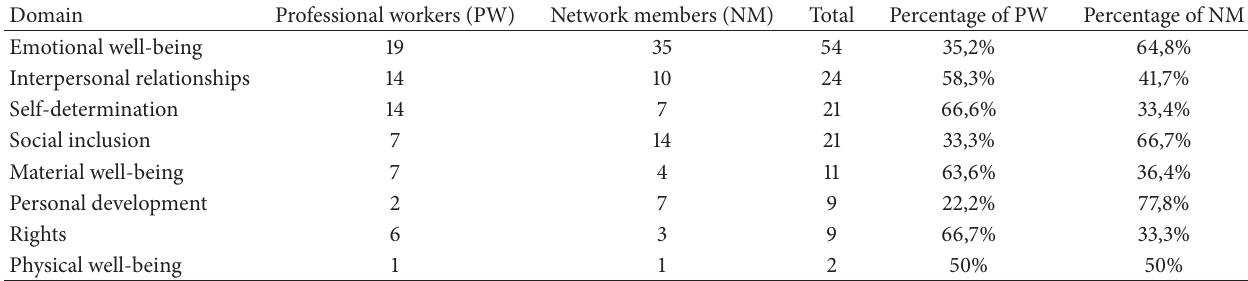
Table 1: Number of statements organized within the eight domains of QOL by Schalock et al. [6] for professional and natural network members